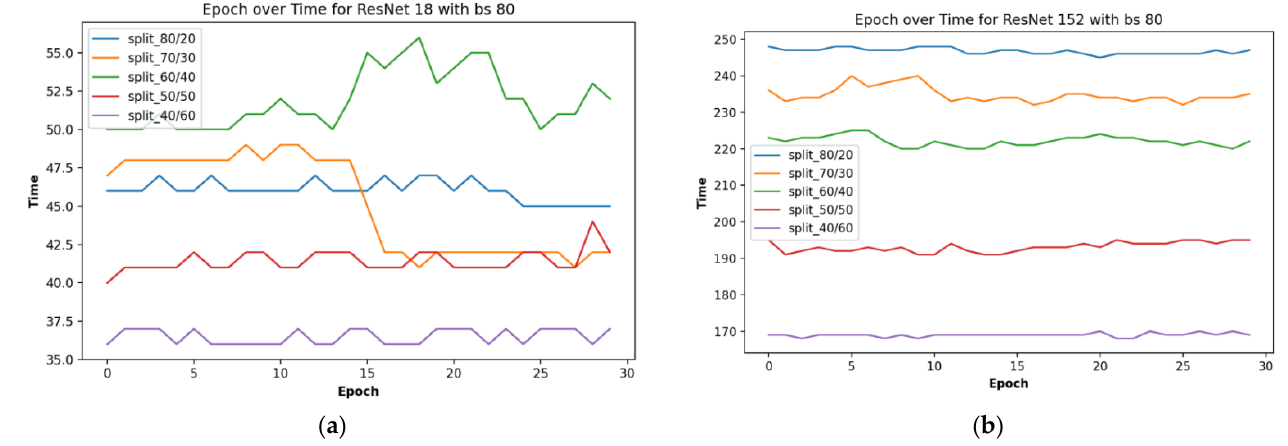
Figure 9. Epoch over time for depth of ( a ) 18, and ( b ) 152.